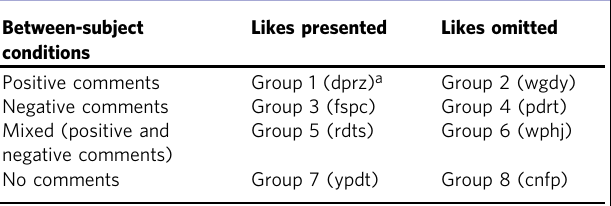
Table 1 Between-subject conditions in the online